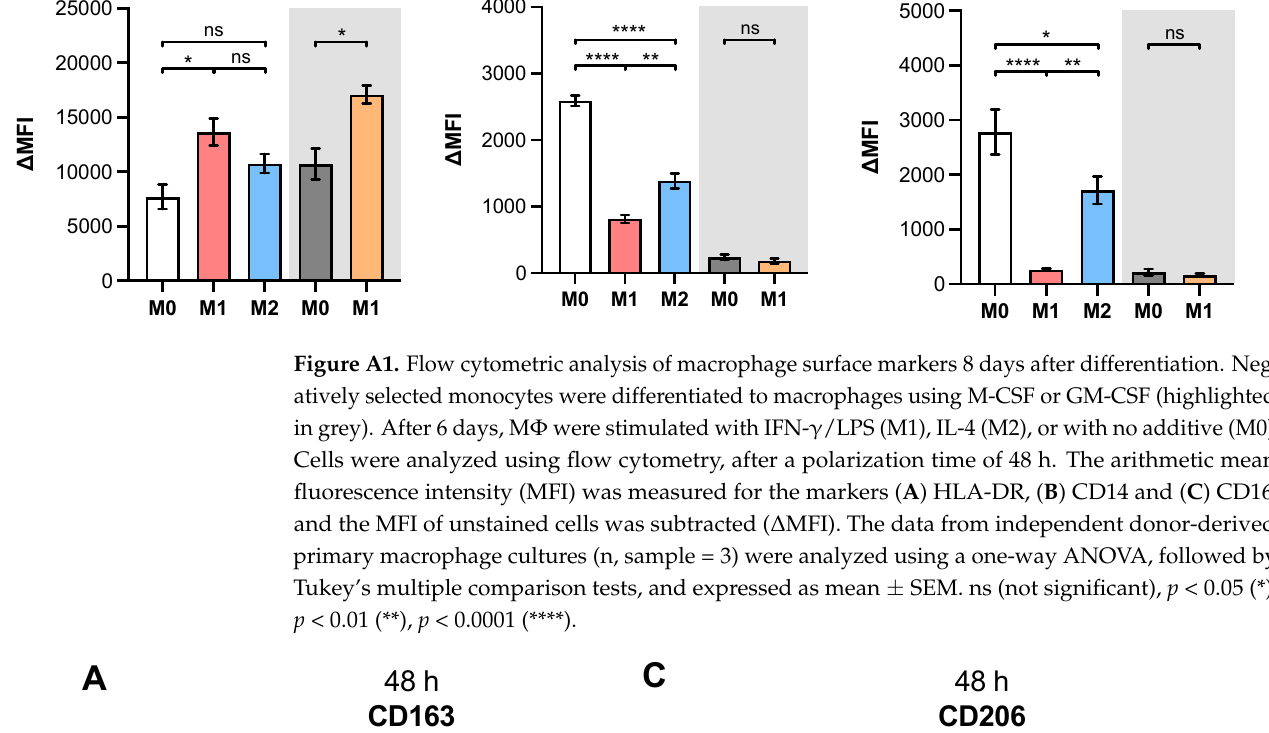
p < 0.01 (**), p < 0.0001 (****).